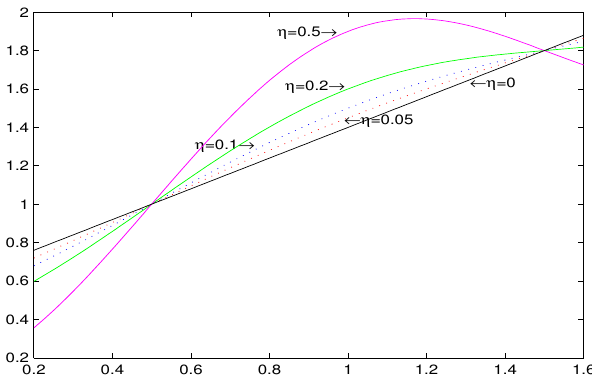
Figure 3. Trajectories of m ( z it ) with η = 0, 0.05, 0.1, 0.2, and 0.5,